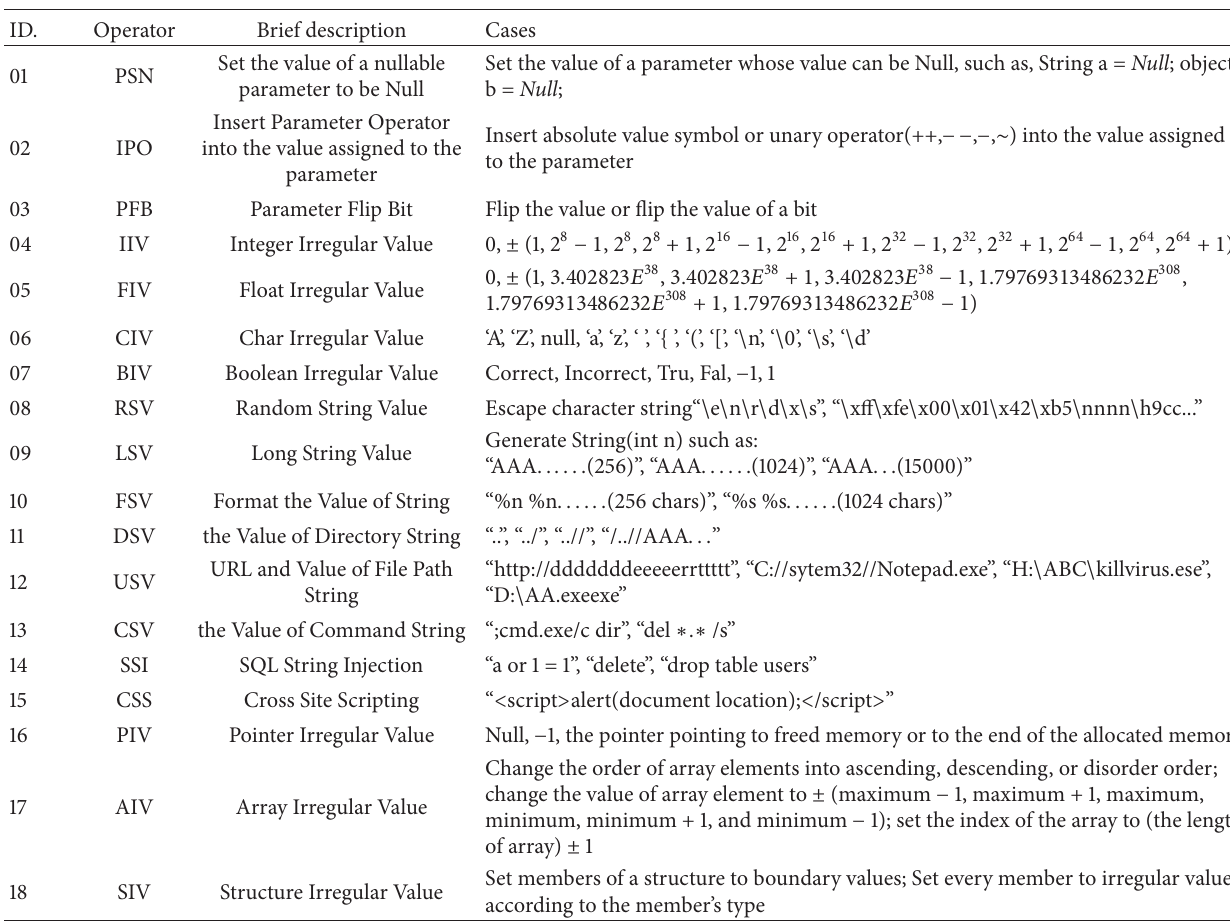
Table 2: Mutation operators of parameters of different